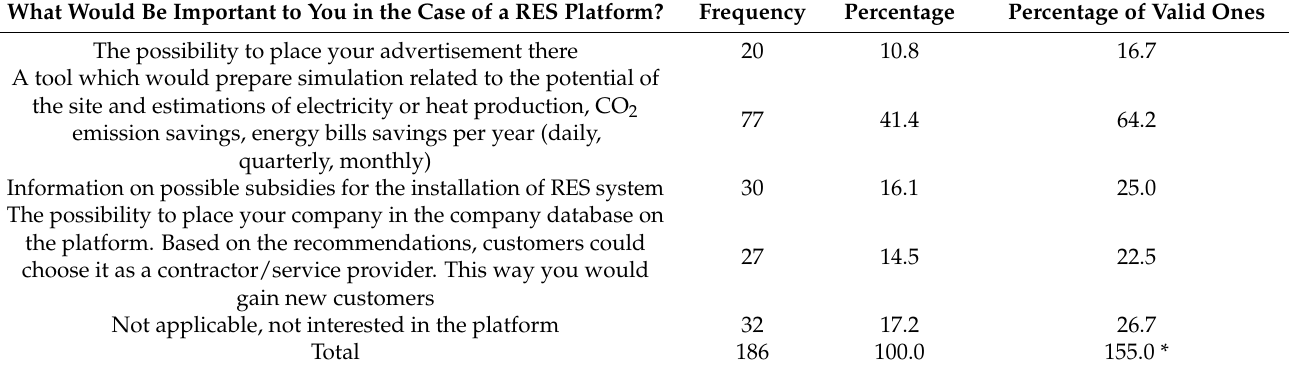
Table 10. Elements of the RES platform important to respondents.